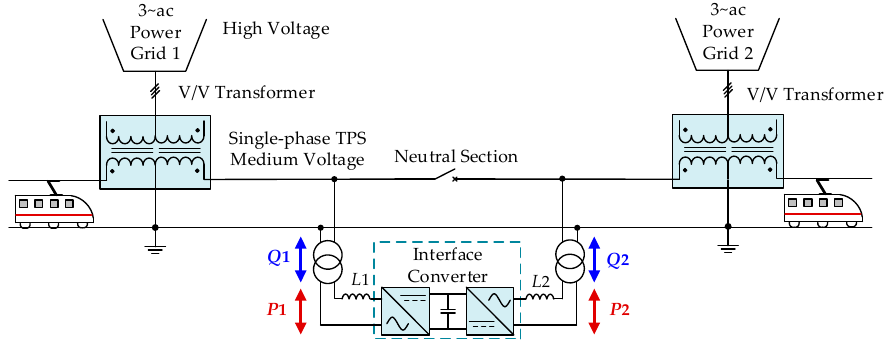
Figure 31. Interface converter between two traction substations.